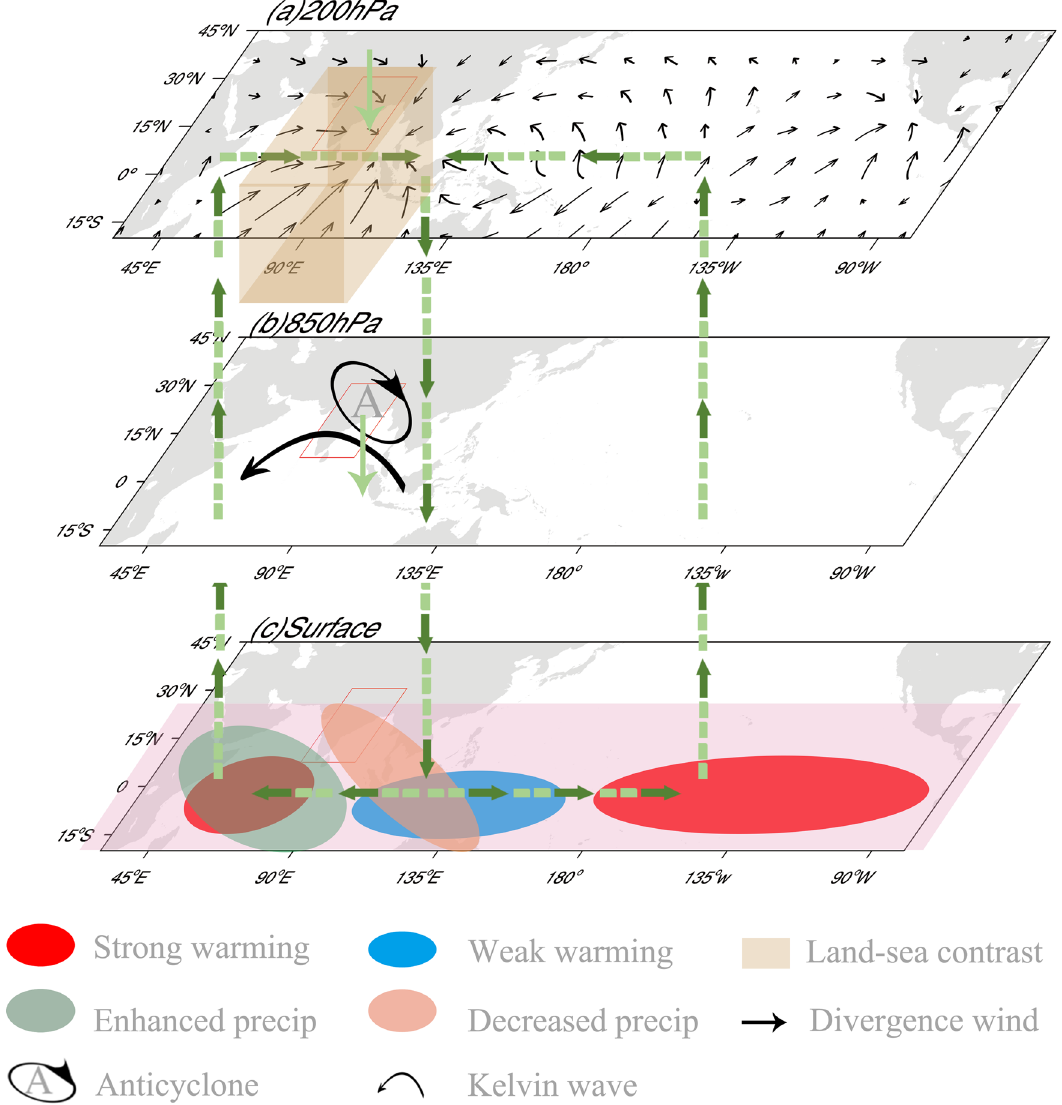
Fig. 11 Schematic diagram showing the key processes involved in the asymmetric response of SASM precipitation under the CDR scenario. The processes at the 200 hPa ( a ), 850 hPa ( b ), and surface ( c ),